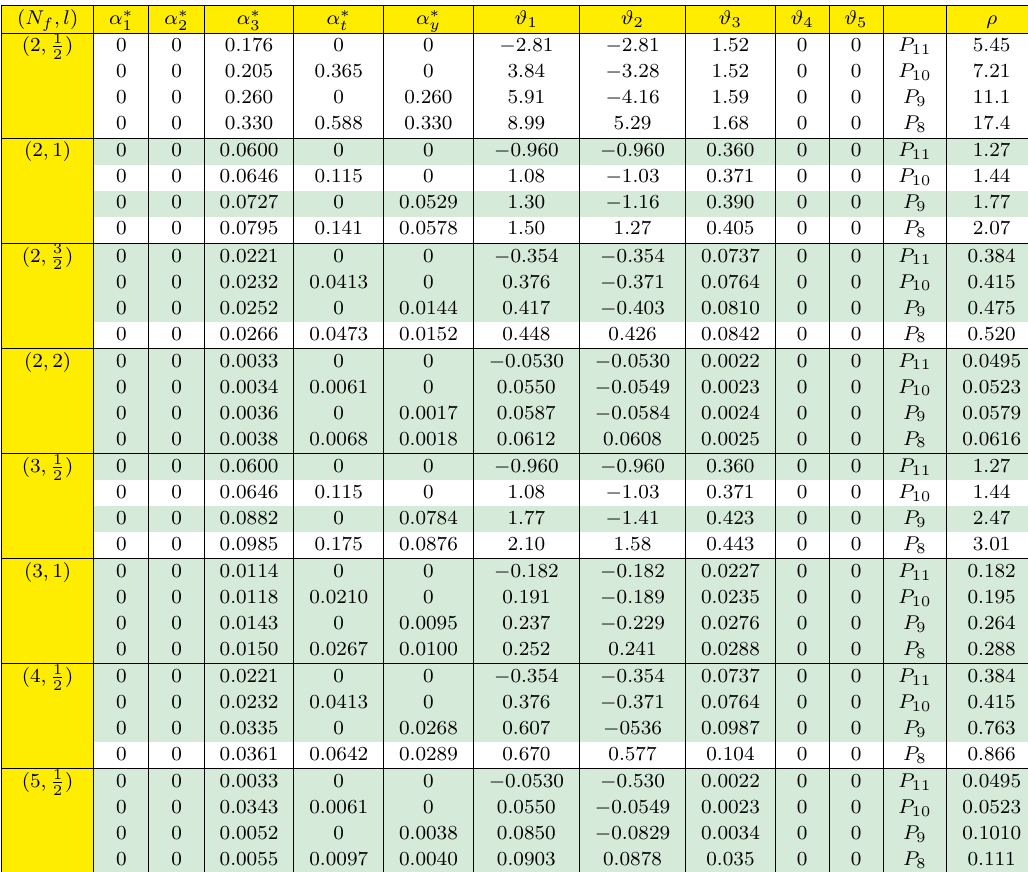
Table 6 . Same as table 5 but with N f >